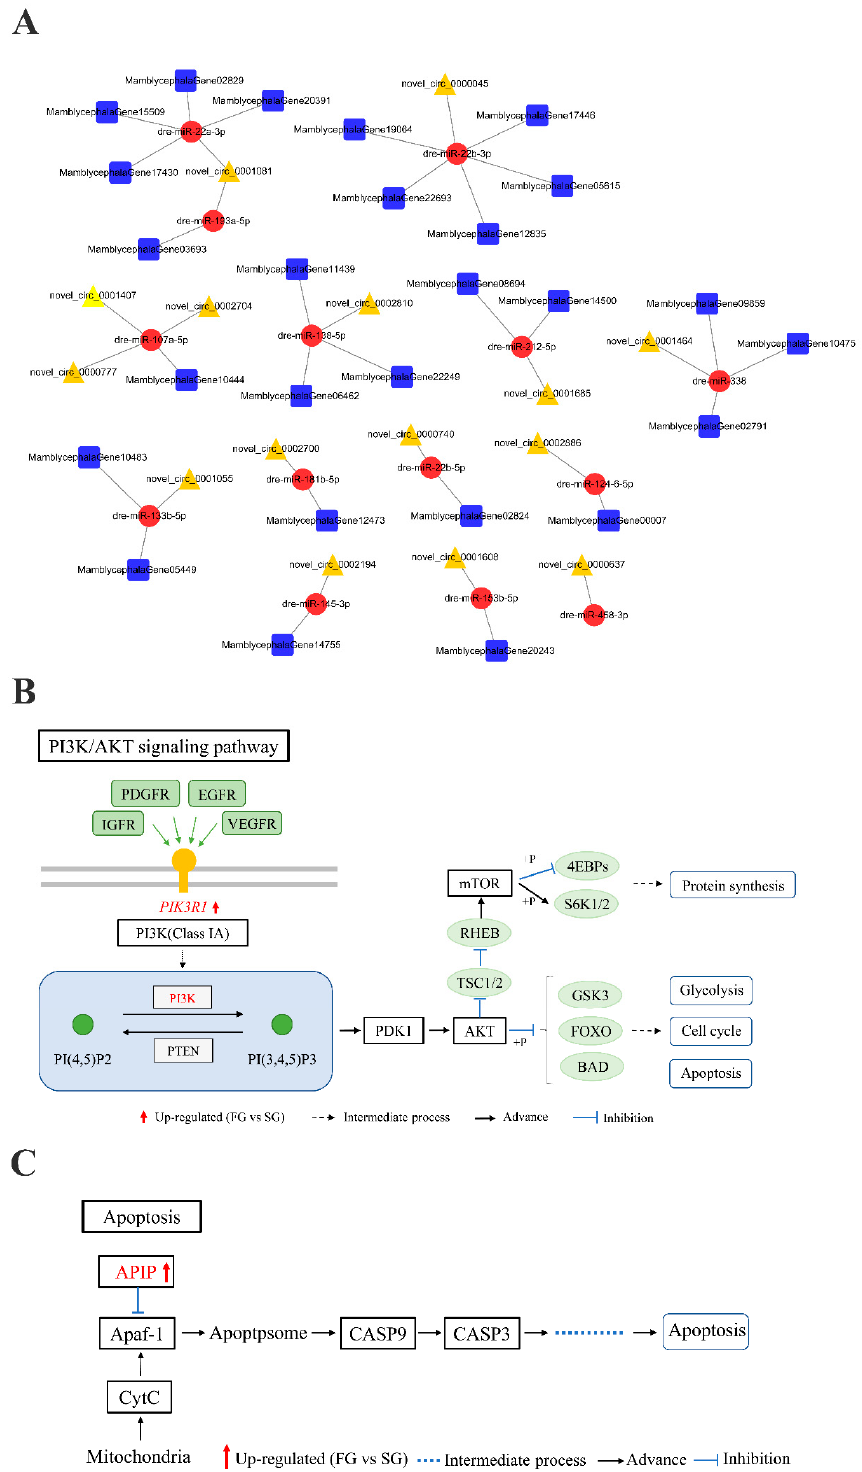
Figure 6. The circRNA–miRNA–mRNA interaction networks and the schematic diagram of key signaling pathways. ( A ) The networks of circRNA–miRNA–mRNA. Red circle nodes represent miRNAs, yellow triangle nodes represent circRNAs; and blue squares represent mRNAs. ( B ) The schematic diagram of PI3K/AKT signaling pathway. ( C ) The schematic diagram of Apaf-1/caspase-9 apoptosis pathway. The red arrow represents the up-regulated (FG vs. SG); the dotted line represents the intermediate process; the black arrow represents the advance; and the blue line indicates